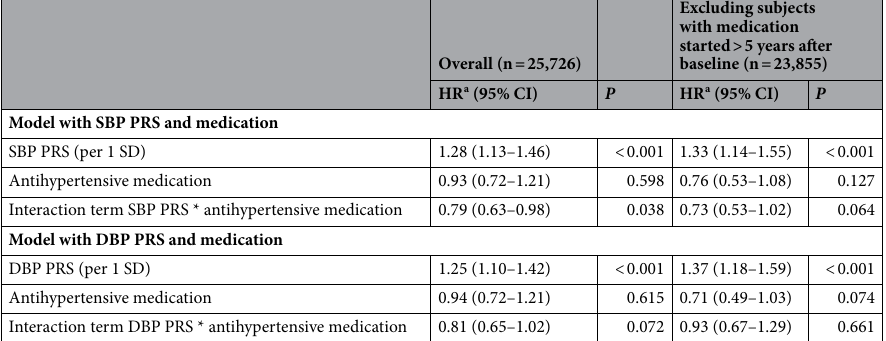
Table 3. Joint associations and interaction between hypertension polygenic risk scores (PRSs) and antihypertensive medication for liver-related outcomes among 25,726 subjects that were medication-naïve at baseline. Analyses are by Cox regression analyses. CI, confidence interval; HR, hazards ratio; SBP, systolic blood pressure; DBP, diastolic blood pressure; PRS, polygenic risk score. a Adjusted for age, sex, body mass index, waist circumference, weekly alcohol use, fraction of alcohol use as wine, low-density lipoprotein cholesterol, high-density lipoprotein cholesterol, triglycerides, diabetes, exercise habits, smoking status (current, former, never smoker) and baseline cardiovascular disease, genotyping chip and the first three principal components of genetic